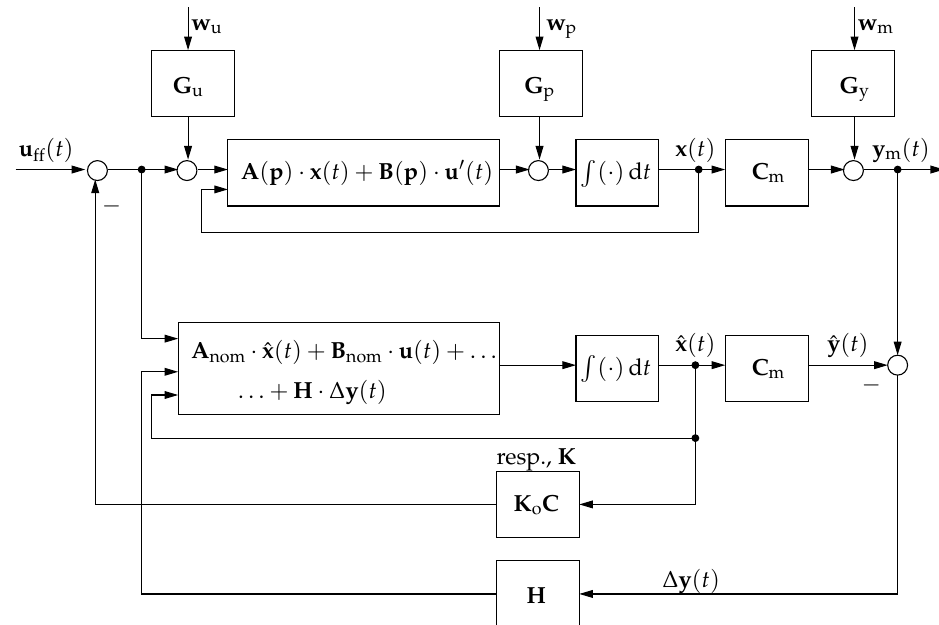
Figure 1. Observer-based state and output feedback control structure according to Case 1 with the gain matrix K and Case 2 with the structured gain K o C